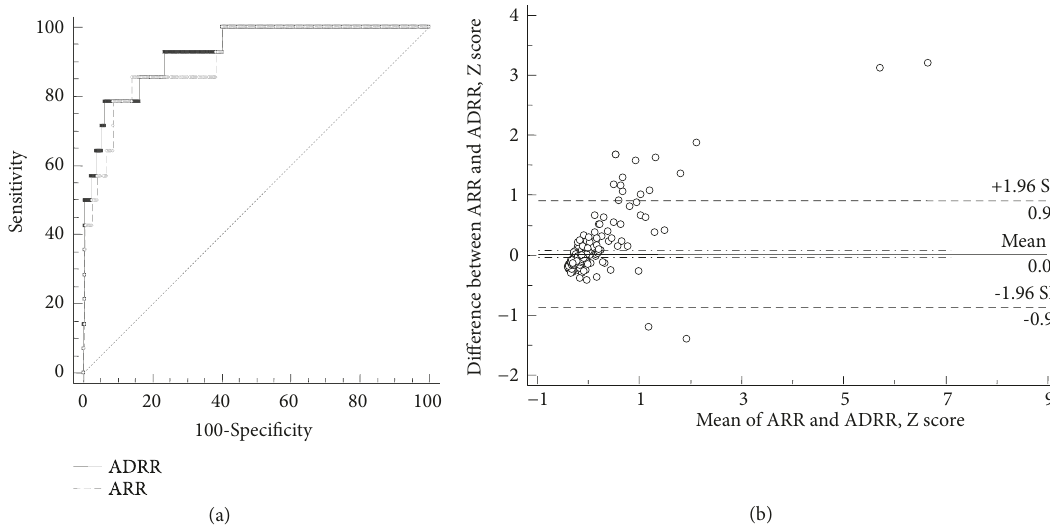
Figure 4: ROC curves andBland–Altman plot for ADRRandARR. (a) This analysis was performed based on thescreening testvalues of ADRR and ARR. Continuousline: ROC curvefor ADRR, 0.929 (95% CI: 0.894-0.955); dashed line:ROC curvefor ARR, 0.910 (95% CI: 0.873-0.940). P=0.42. (b) There was no significant systematic bias. ADRR: aldosterone-to-direct renin concentration ratio; ARR: aldosterone-to-plasma renin activity ratio; CI: confidence interval.